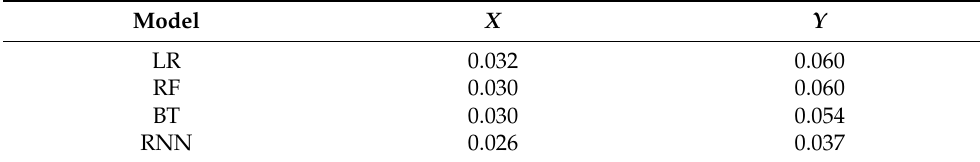
Table 2. Accuracy (m) in X − Y − Z directions.